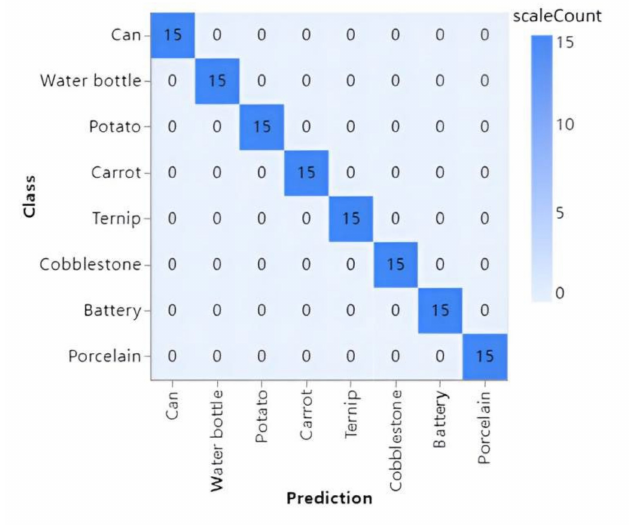
Figure 8. Confusion matrix image of test set results. The prediction results of all test sets for the eight categories are consistent with the actual